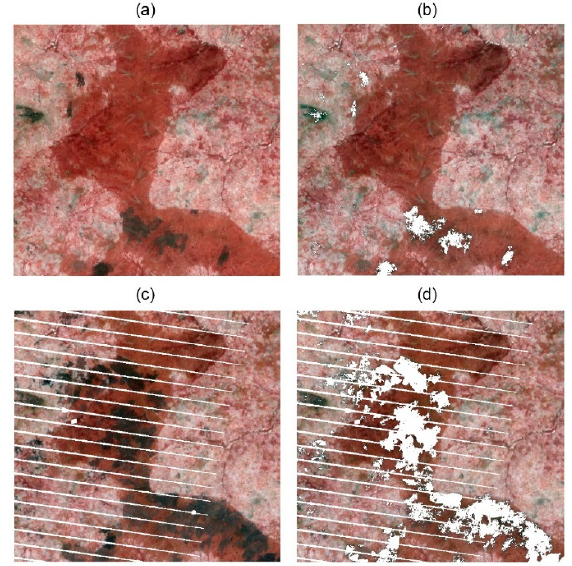
Figure 5. Burnt area detection result for ( a , b ) 14 December 2013 Landsat 8 image and for ( c , d ) 7 Jan 2014 Landsat 7 image. The detected burnt areas and missing data of Landsat 7 ETM+ SLC-off image are shown in white.